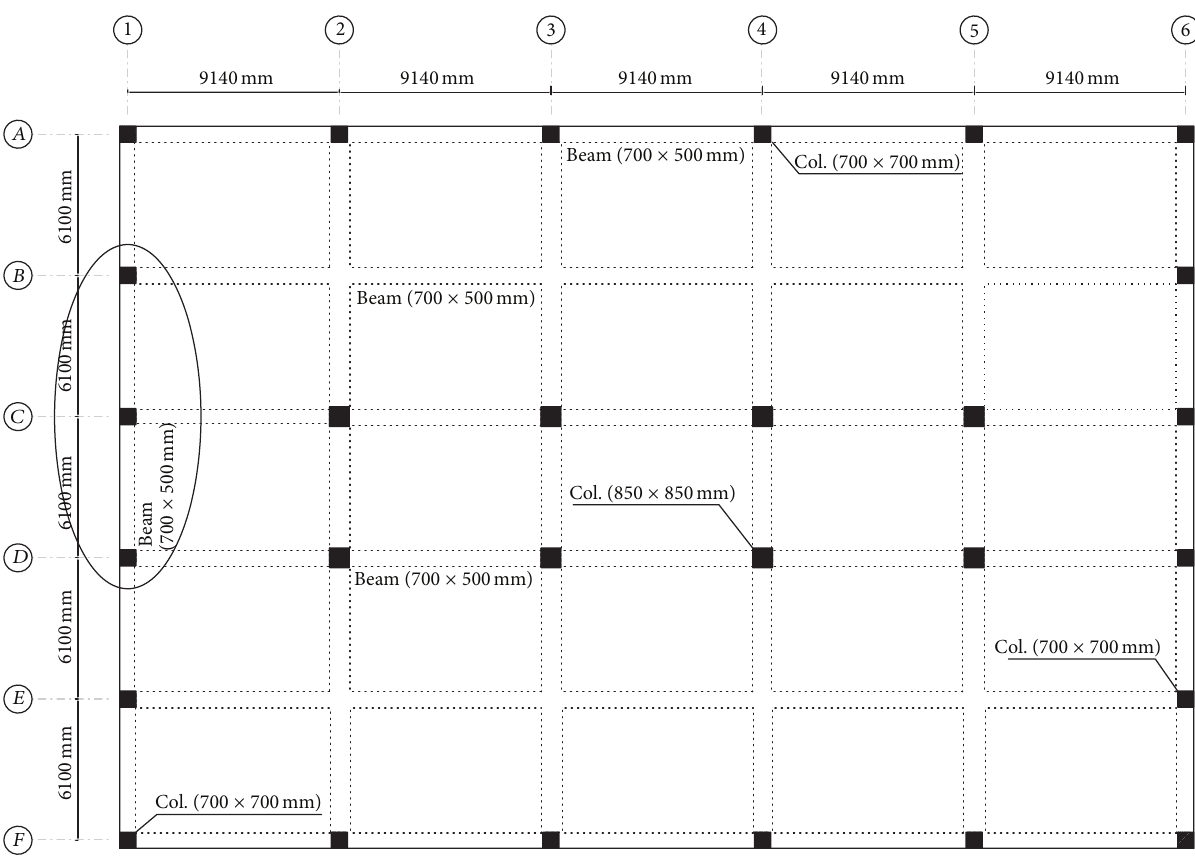
Figure 1: Plan layout of prototype